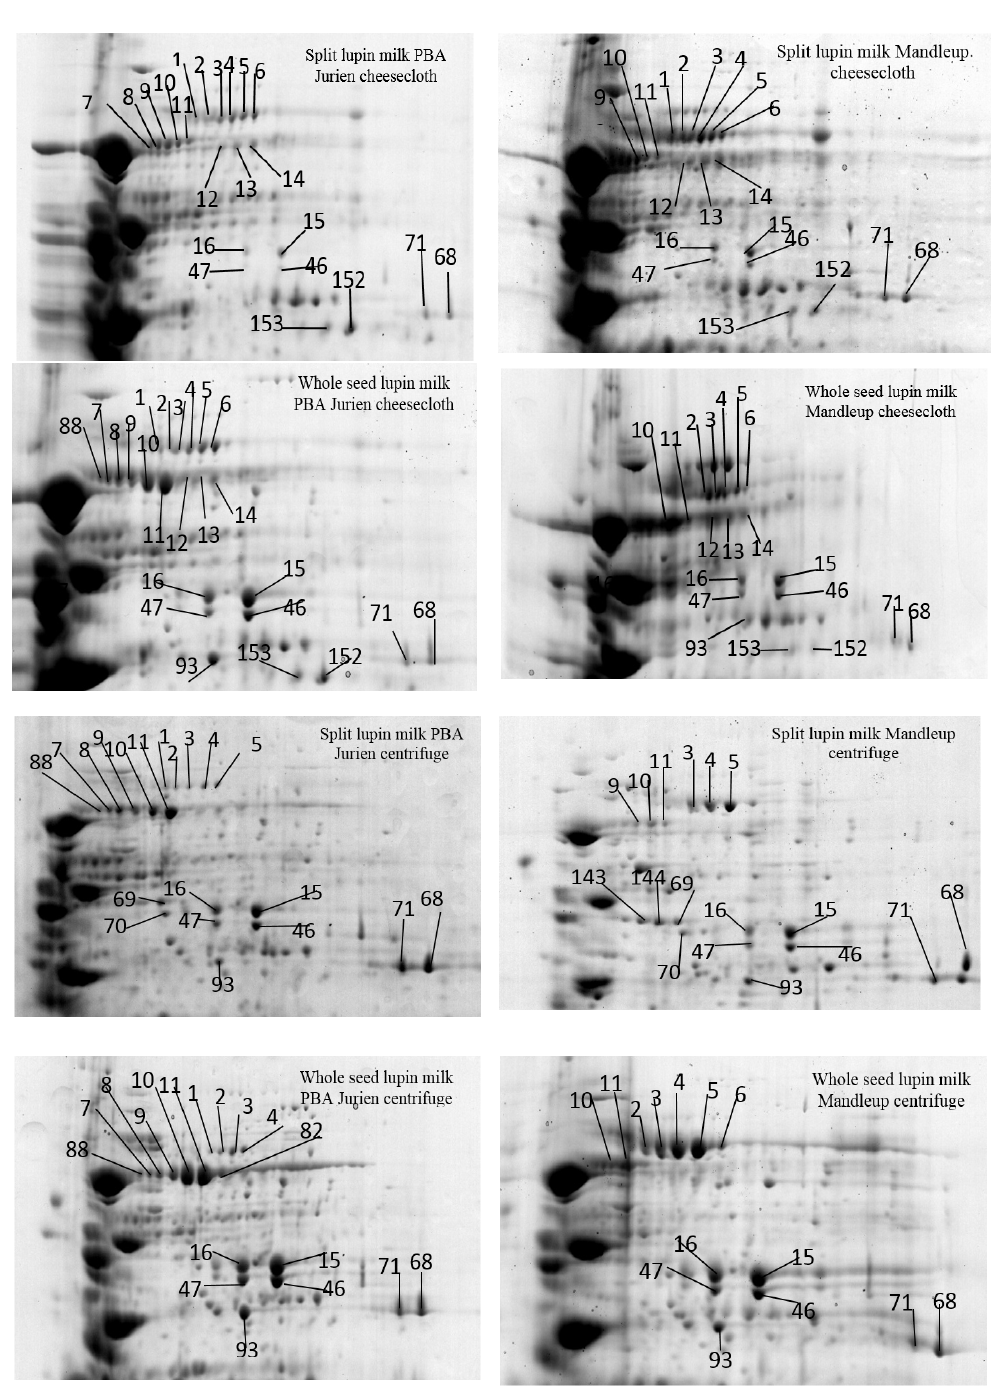
Figure 3. Comparison of differentiating protein abundance extractability between region a and b displayed in Figure 2 in lupin milk as influenced by seed coat and two separation techniques—cheesecloth and centrifuge—of the two